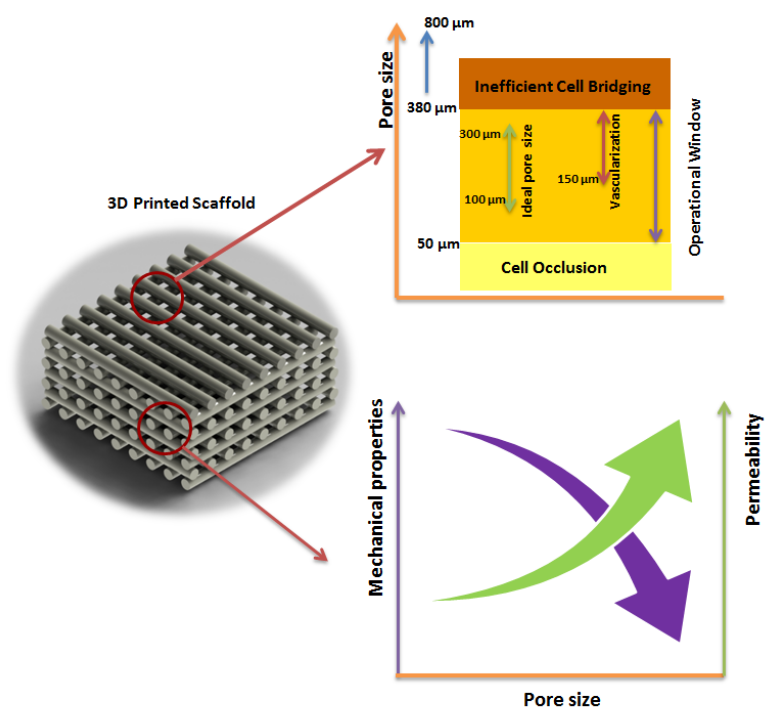
Figure 1. The effect of pore size on the mechanical and biological performance of printed scaffolds